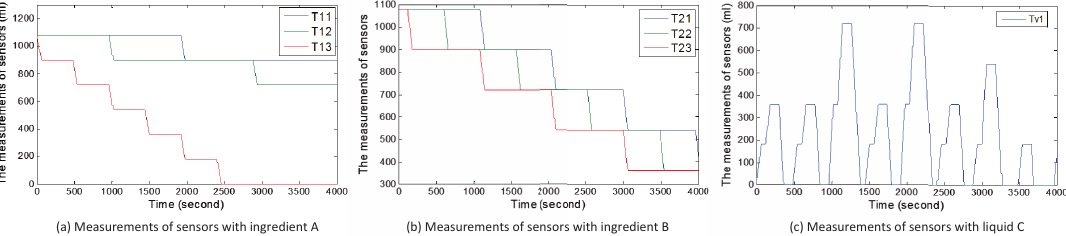
Figure 12. Measurements from sensors under attack case